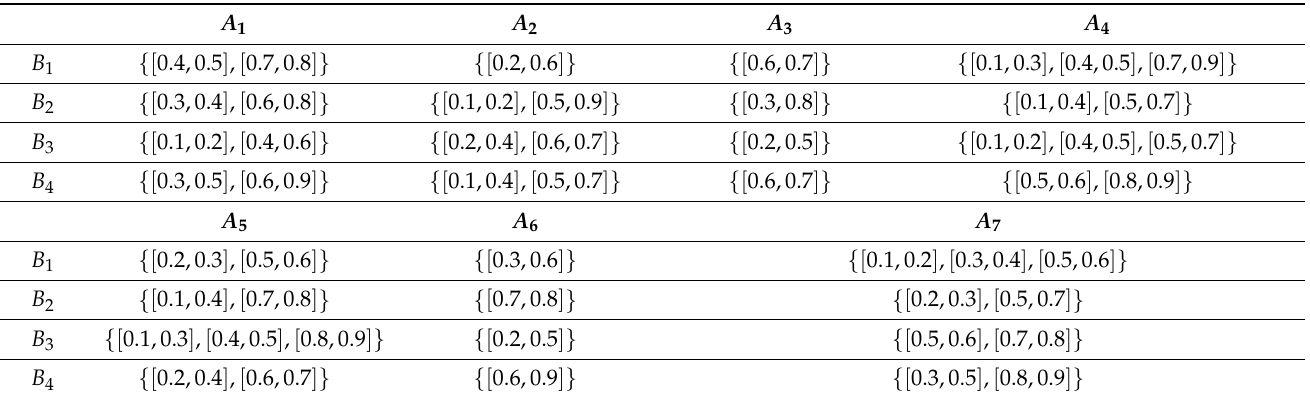
Table 3. Interval-valued hesitant fuzzy preference matrix 2.